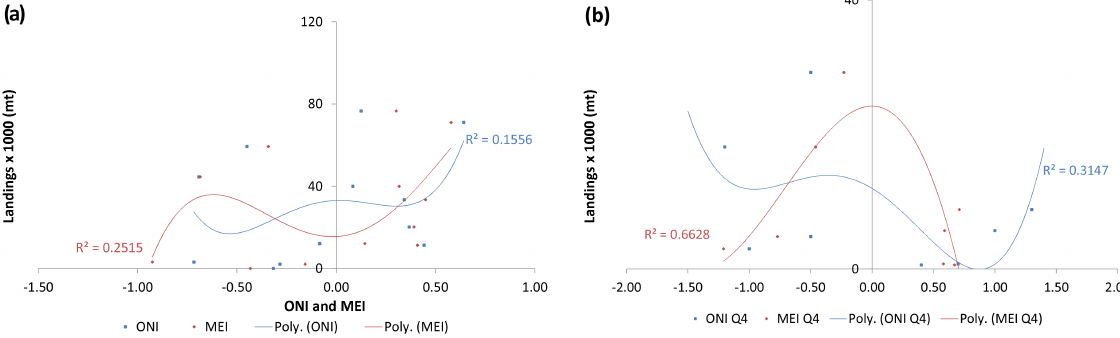
Figure 7. Yearly and Q 4 anchovy landings vs. the ONI and MEI (2001–2012), n = 4. Q 4 (T4) vs. MEI ( n = 3).